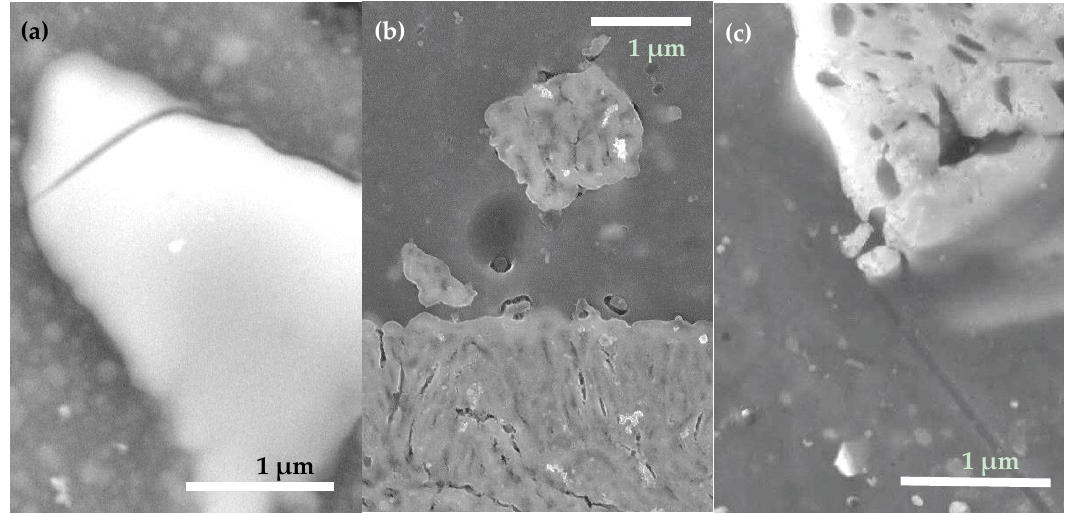
Figure 7. Surface SEM images of samples 4 ( a ), 5 ( b ), and 6 ( c ) after immersion in DI water for 72 h.